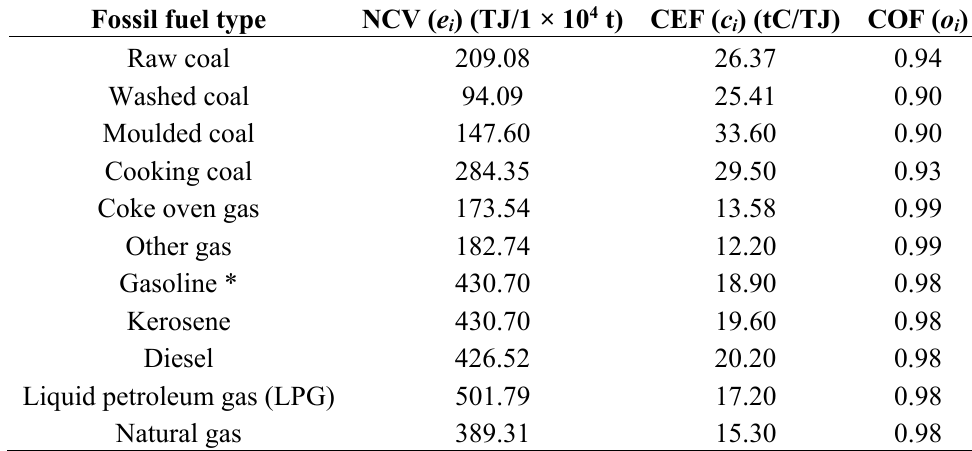
Table 1. Net calorific value (NCV), carbon emission factor (CEF) and fraction of oxidized carbon (COF) for different fossil fuels used in China.